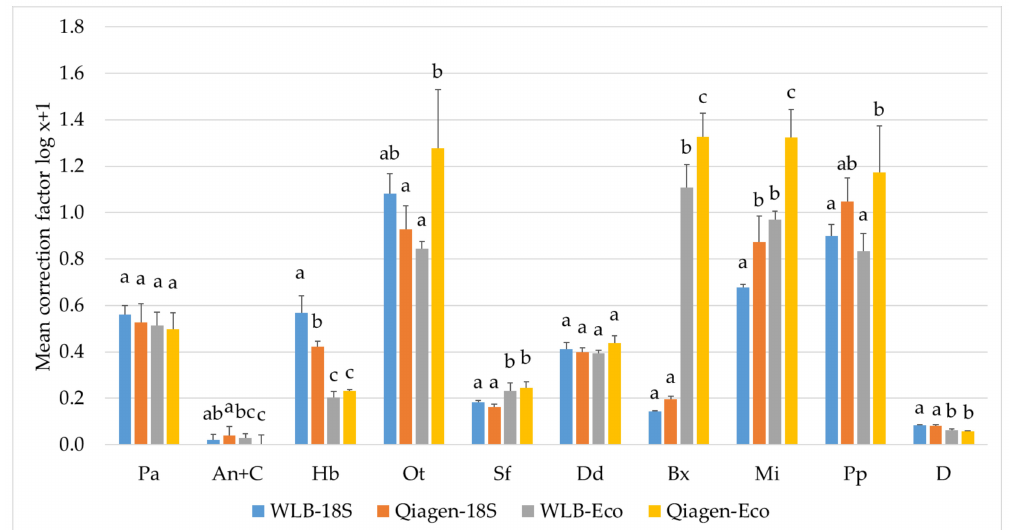
Figure 5. Mean correction factors (log x+1) calculated for each nematode species (see Table 1) and procedure (WLB-18S: DNA-extraction based on the adapted Holterman method and NemFopt